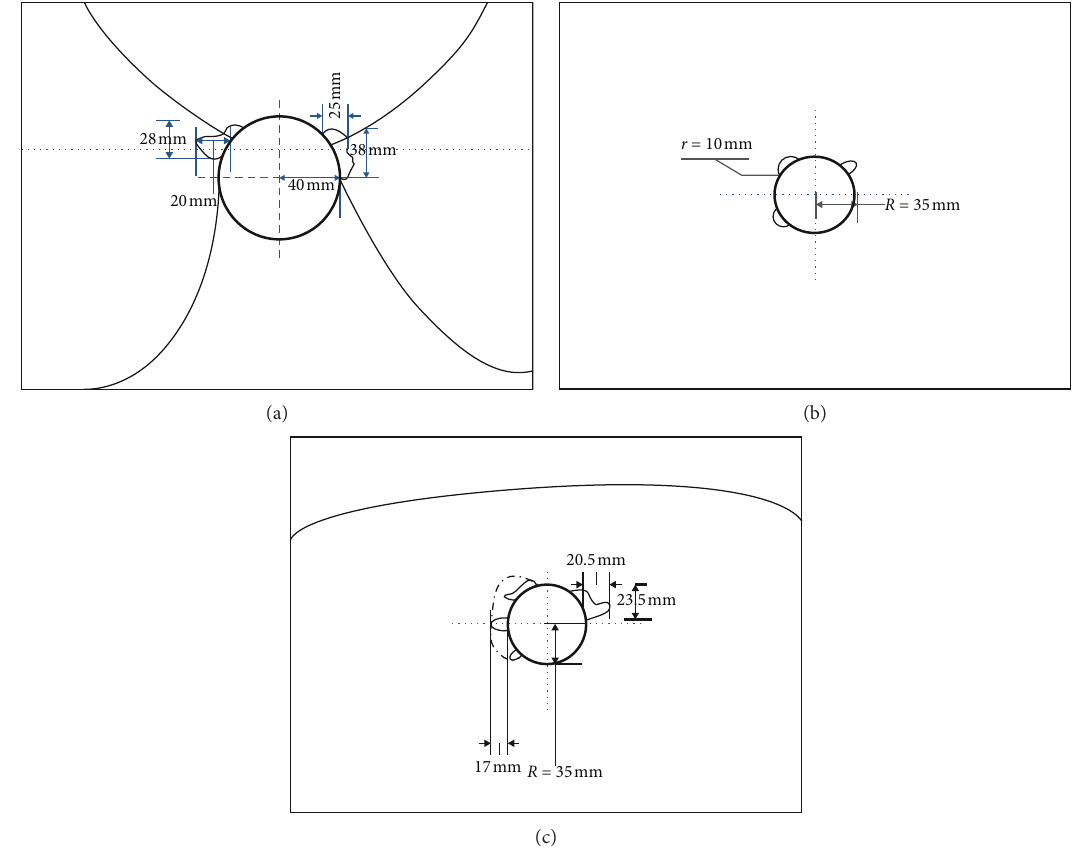
Figure 23: TBM tunnel surrounding rock deformation sketch of mixed strata with and without support. (a) Without support. (b) Support 1. (c) Support 2.